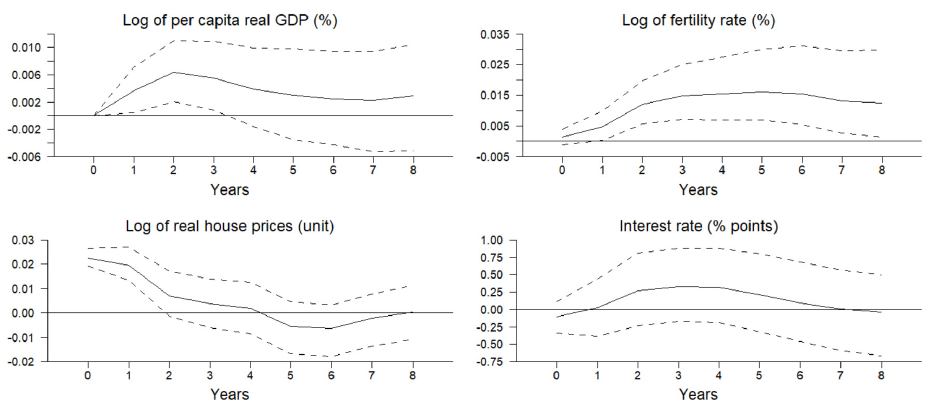
Figure 3. Responses to a house price shock in the baseline SVAR.